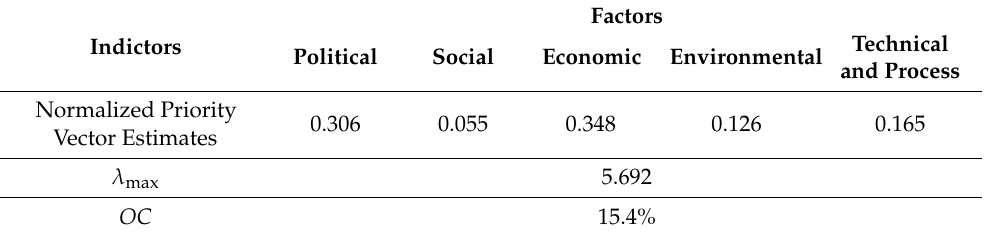
Table 1. Results of assessing factors’ impact on the development of the Iraqi gas industry.